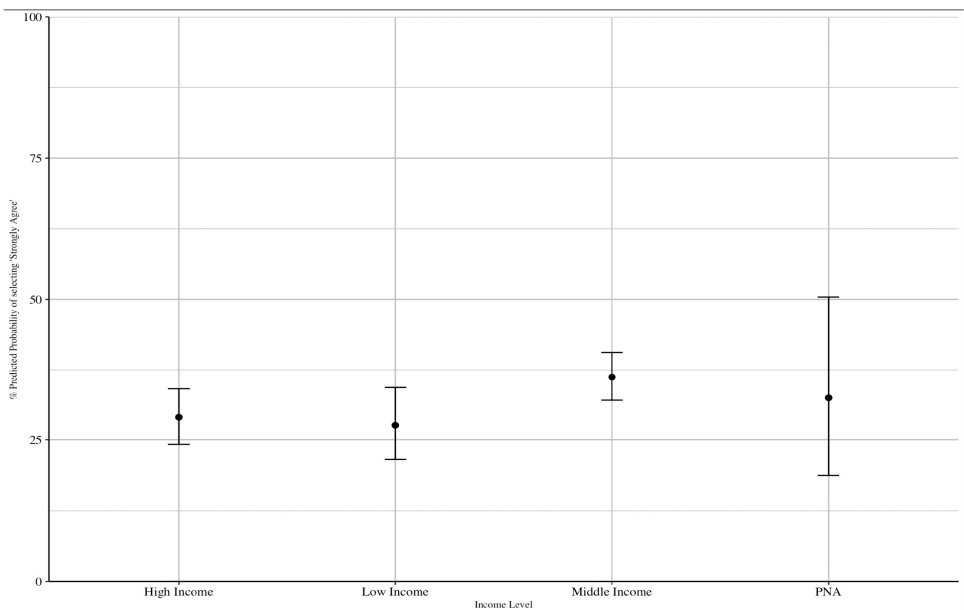
Figure 2. Predicted probability of selecting “Strongly Agree” to long-term health risks based on income level.